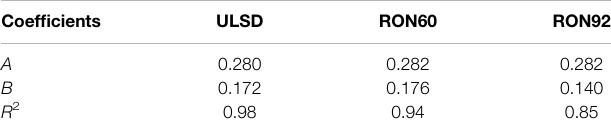
TABLE 4 | Fit coef fi cients and R 2 values for non-vaporizing dispersion angle correlation in Eq. 1 and Figure 13 .